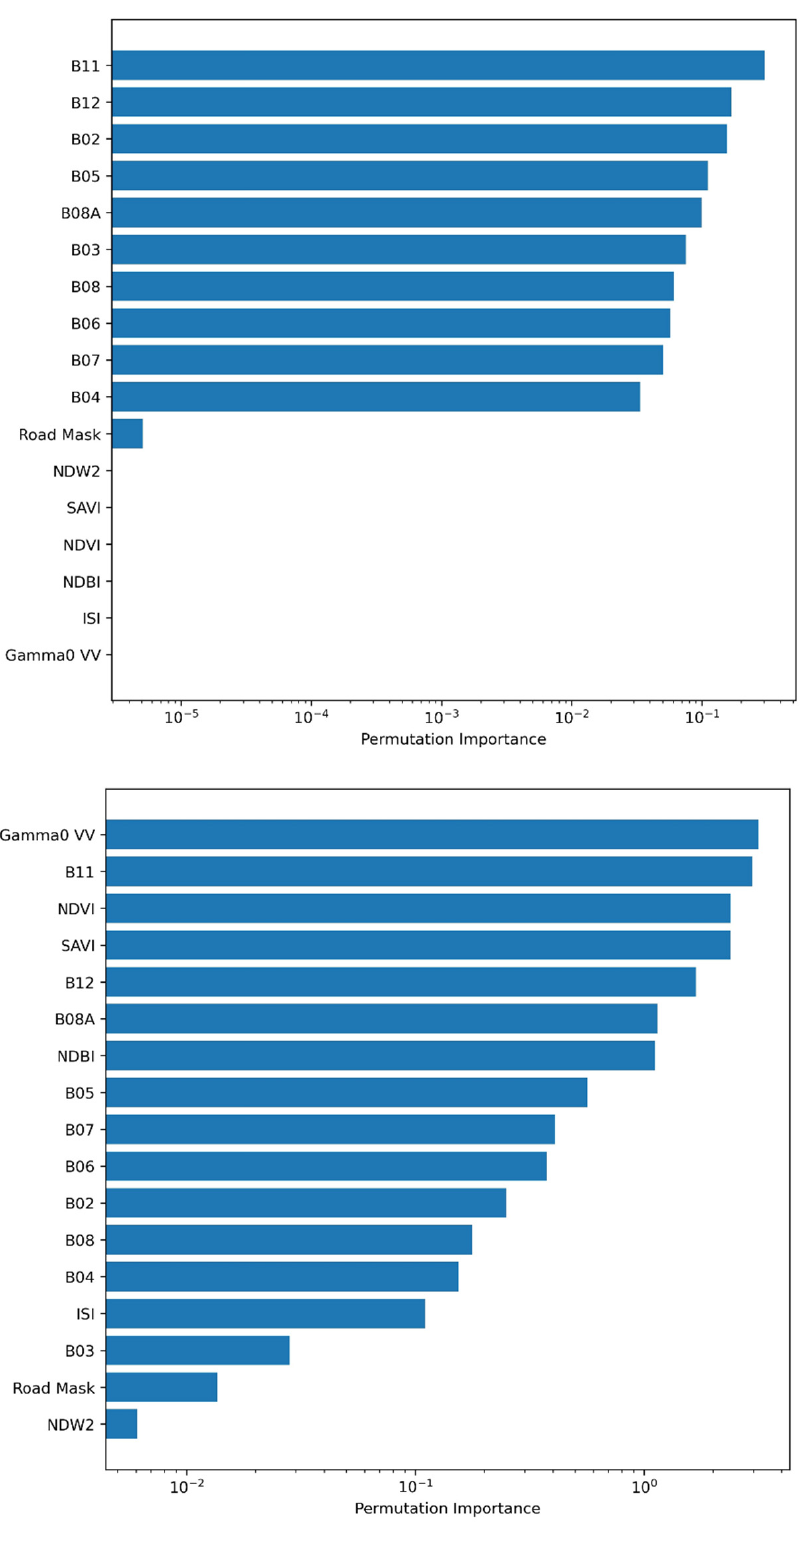
Figure 4. Linear Regression ( top ) and Random Forest ( bottom ) layer importance.